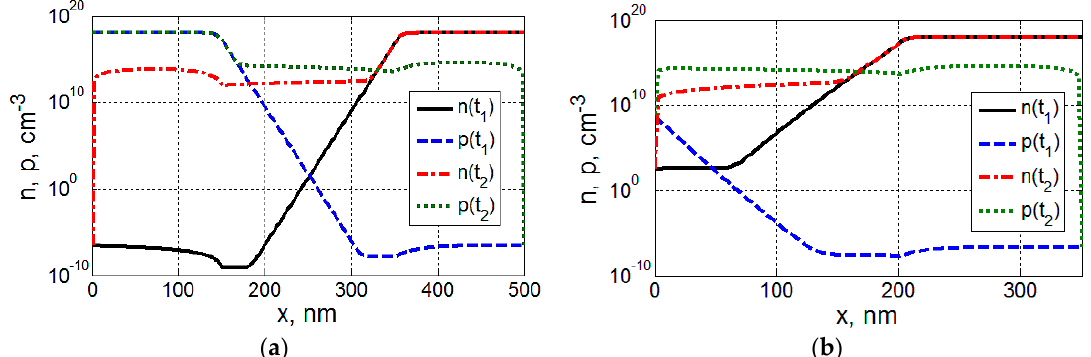
Figure 4. Electron (n) and hole (p) concentrations in the structures of GaAs p-i-n ( a ) and n-type Schottky-barrier ( b ) photodiodes at the instants of the leading ( t 1 ) and back ( t 2 ) edges of the rectangular laser pulse.